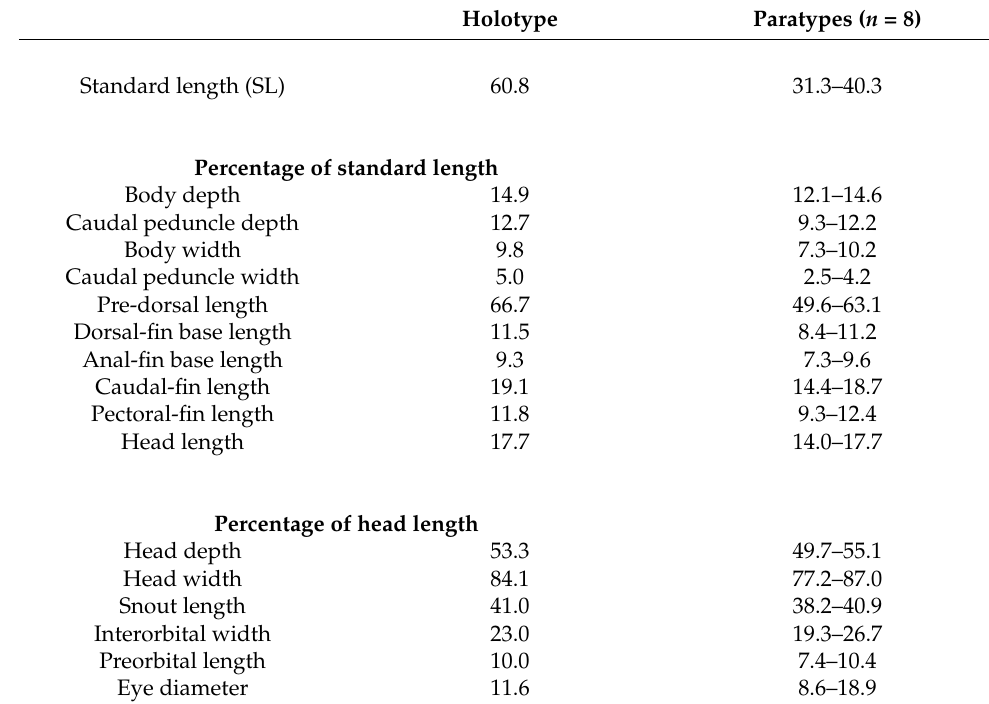
Table 4. Morphometric data of Trichomycterus uberabensis Costa, Azevedo-Santos & Katz sp.